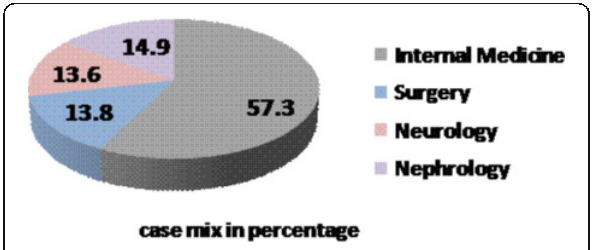
Fig. 26 (abstract A55). Case mix of